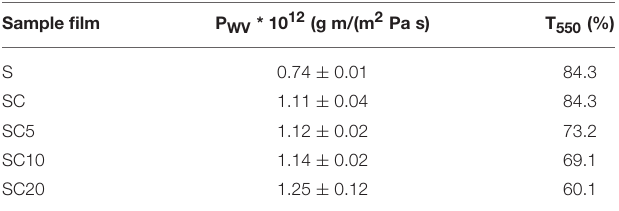
TABLE 4 | Water vapor permeability (P WV ) and UV-Vis transmittance at 550nm (T 550 %) for the neat PET substrate film (S) and for the SC coated films at 0, 5, 10, and 20% LAE concentration.